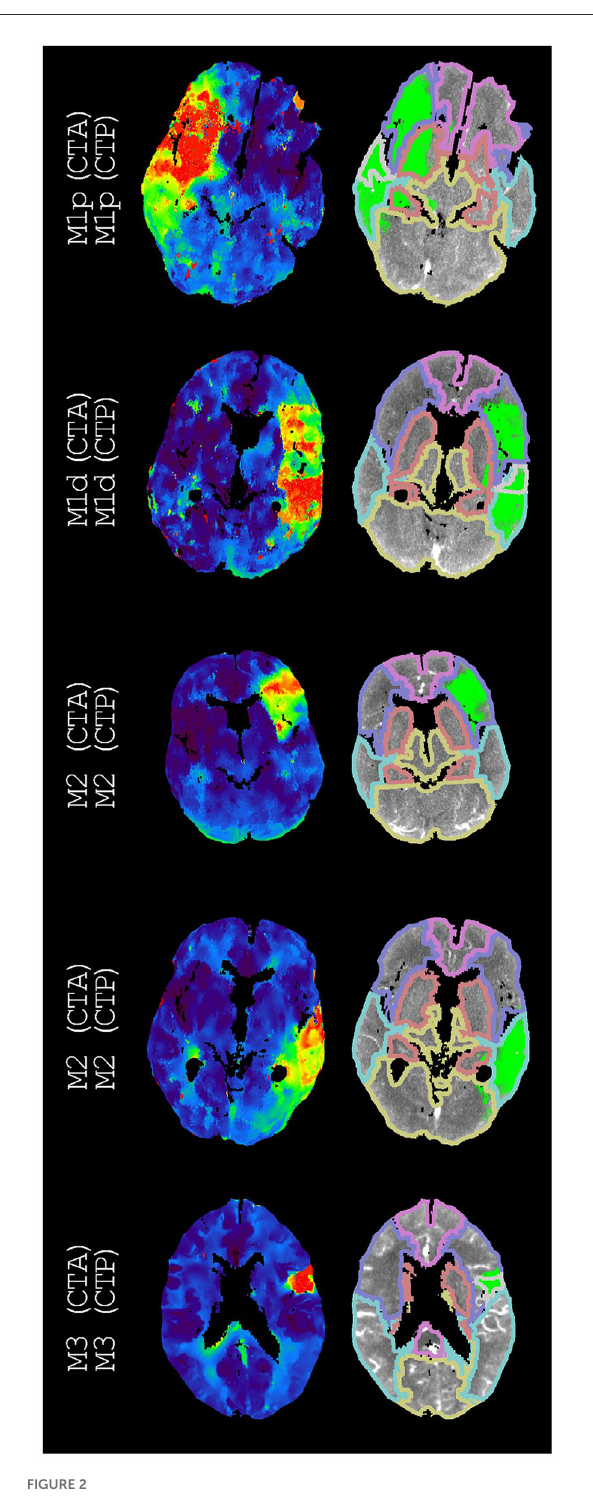
FIGURE2 Examples of annotations (CTA) and indications (CTP) that match different segments of the middle cerebral artery. On the left, time-to-peak perfusion maps are shown. On the right, the hypoperfused regions and the downstream regions (according to Figure 1) are shown. For each example, we only regarded the M3 downstream region with the highest intersection-over-union. If displayed, these M3 downstream regions are the superior temporal region, the superior temporal region, and the precentral region (from top to bottom).